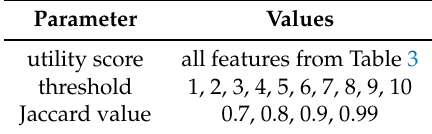
Table A26. Hyperparameter search space for collective classification.